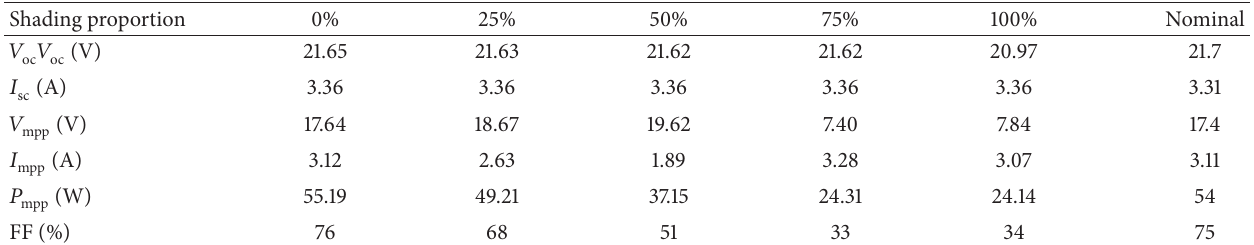
Figure 3: Different types of shading in a large scale grid-connected PV plant in northwest China. (a) Power distribution buildings shading; (b) wire poles shading; (c) plants shading; (d) bird droppings shading; (e) tracking PV system shading; (f) fixed PV system shading. Table 2: The measurement results in shading effect